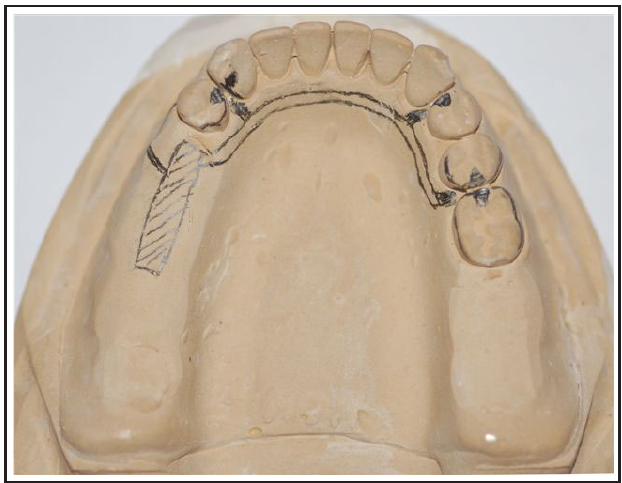
Fig. 3. RPD framework drawn on the study cast to transmit this information to the prosthodontic technician. information to the technician, since subsequent transfer of two-dimensional information by the technician from the paper diagram to the three-dimensional cast can lead to errors of interpretation (Figure 3) 4 . Clarification of the design diagram may be achieved by using a color code to identify different RPD components or